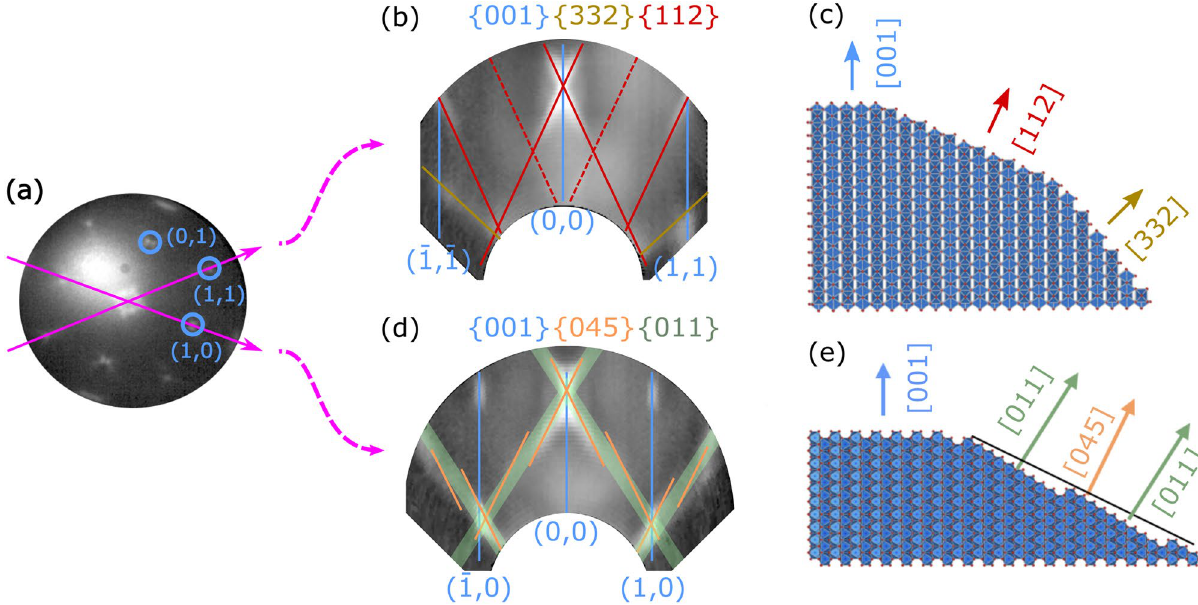
Figure 3. Identification of facet types on the 85nm thick VO 2 film. ( a ) Exemplary µ LEED pattern recorded at 23eV , the highlighted paths illustrate the orientations of the generated reciprocal space maps. The full LEED stack is provided as Supplementary video 1. ( b , d ) Facet directions have been identified in the RSMs and corresponding structural models are given in ( c , e ). The structure models were created by the open source software Vesta 3.4.7 (http:// jp- miner als. org/ vesta/ en/) 24